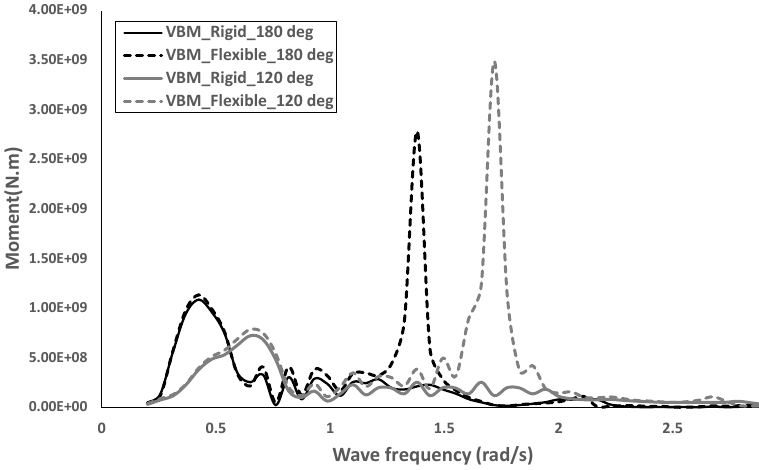
Figure 10. Load transfer function VBM (vertical bending moment).